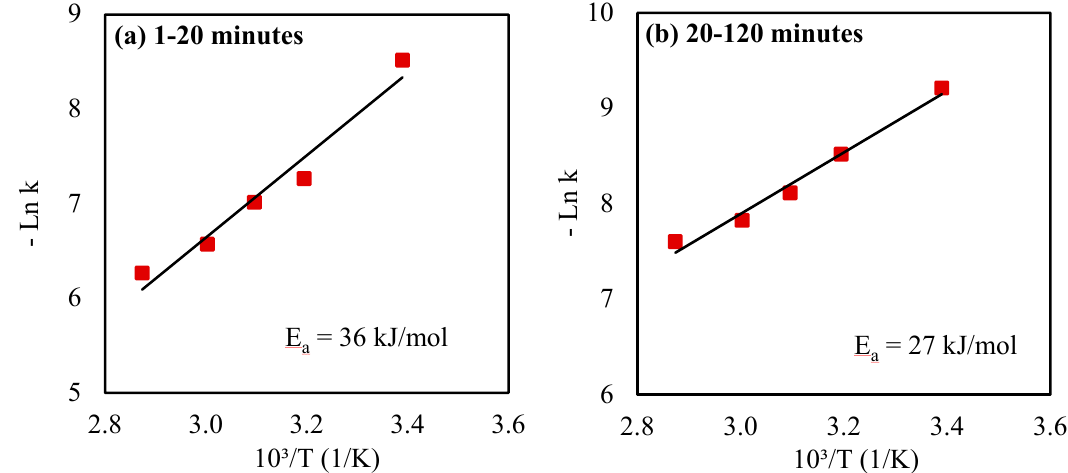
Figure 14. Arrhenius plot for the total REEs leached from the Fire Clay coal middlings during the ( a ) first 20 min, and ( b ) 20–120 min of leaching (1 M H 2 SO 4 , 530 rpm, S / L = 10g / L, d 80 = 8.7 Table 3. Correlation coefficients of diffusion-controlled kinetics models at different temperatures for light REEs.